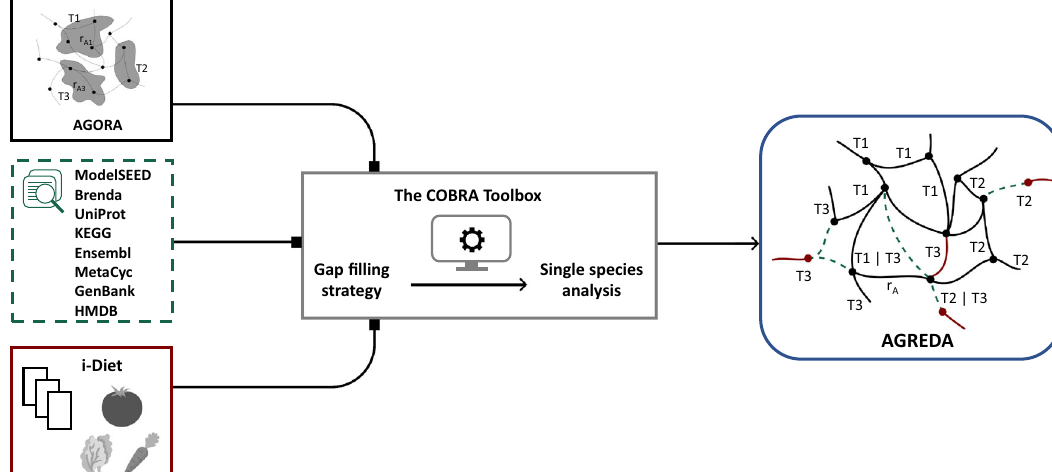
Fig. 1 Summary of the reconstruction pipeline. First, AGORA reconstructions 11 (black) are merged into a single compartment. Duplicated reactions were deleted but the taxonomic assignment was kept. For example, the same reaction r A in taxon 1 (T1) and taxon 3 (T3) in AGORA, r A1 and r A3 , were converted to only one reaction in AGREDA and its associated Boolean rule, T 1 |T 3 , which we term Taxonomy-Reaction (TR) rule. Next, the Model SEED 7 reactions (green) are annotated to AGORA species through EC number information (see “ Methods ” section). Then, metabolites provided by i-Diet and manually curated literature knowledge are integrated with AGORA and the Model SEED (maroon). Finally, gap- fi lling techniques and single-species analysis, based on the Cobra Toolbox 22,23 , are applied to derive